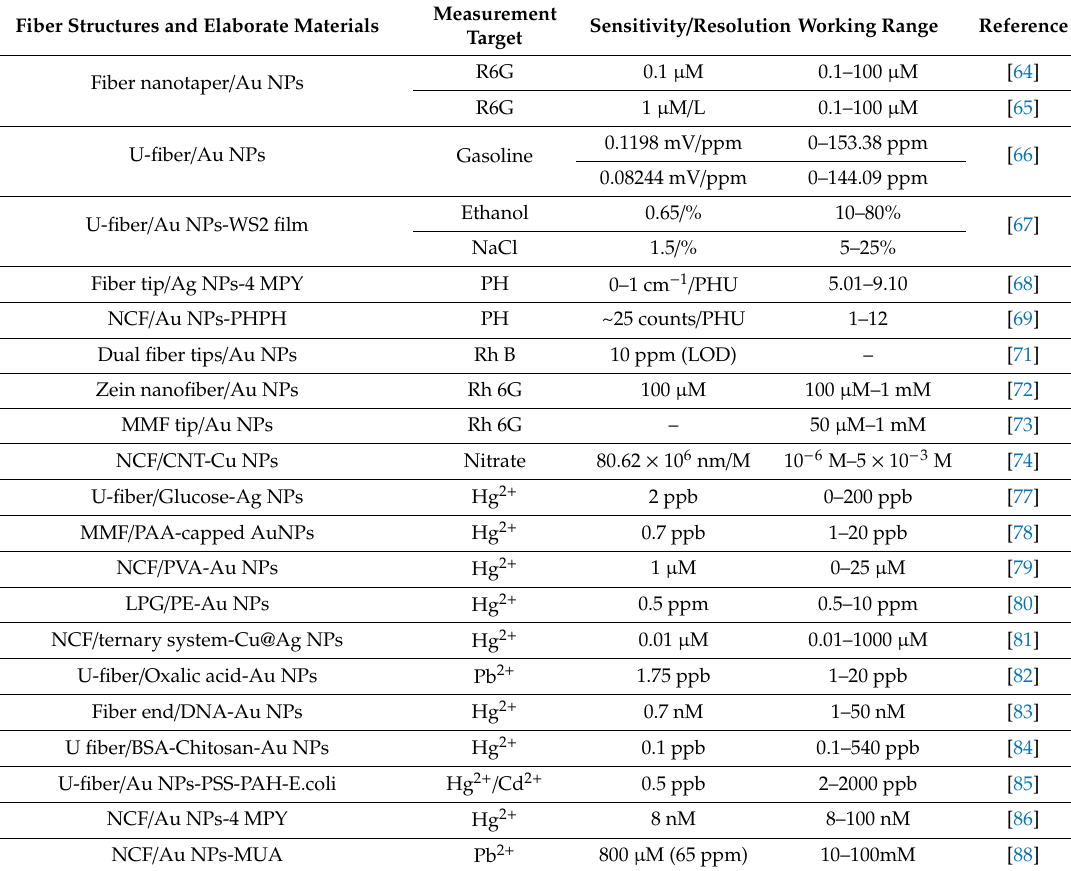
Table 2. Chemical sensing performance comparison for fiber-LSPR